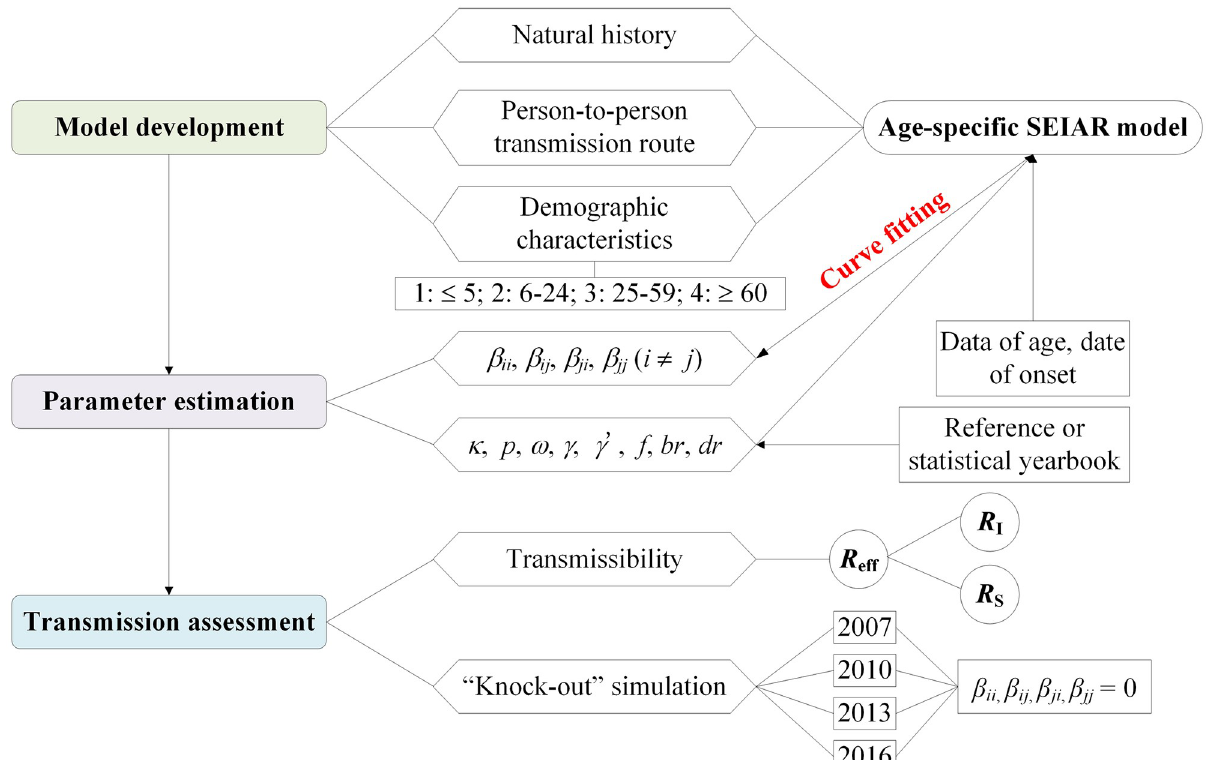
Fig 1. Flowchart of study design from model development to transmission